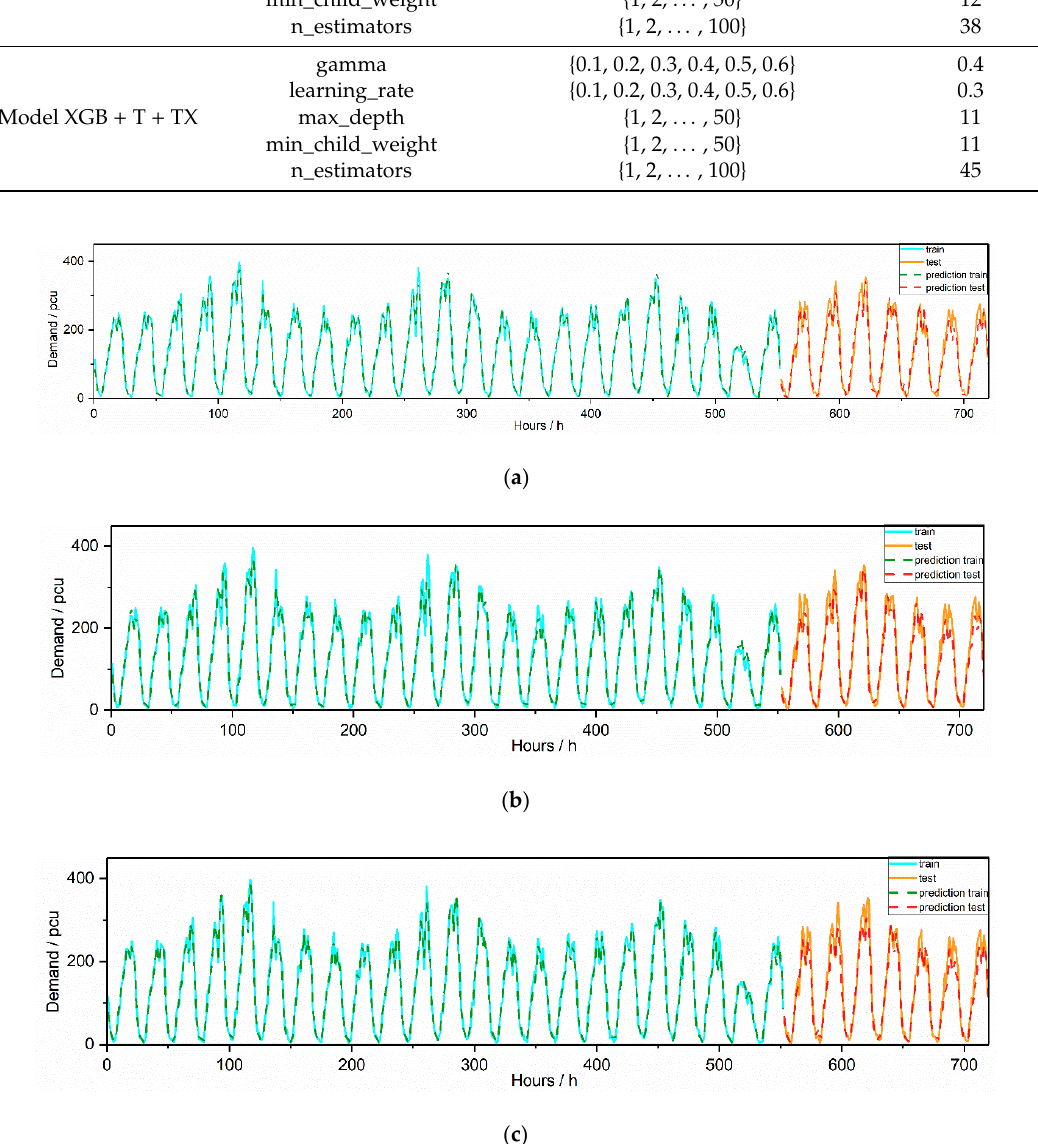
Figure 5. Online taxi-hailing demand prediction results of models based on BPNN. ( a ) Result of model “BPNN + T”; ( b ) Result of model “BPNN + T + E”; ( c ) Result of model “BPNN + T + E + TX”.